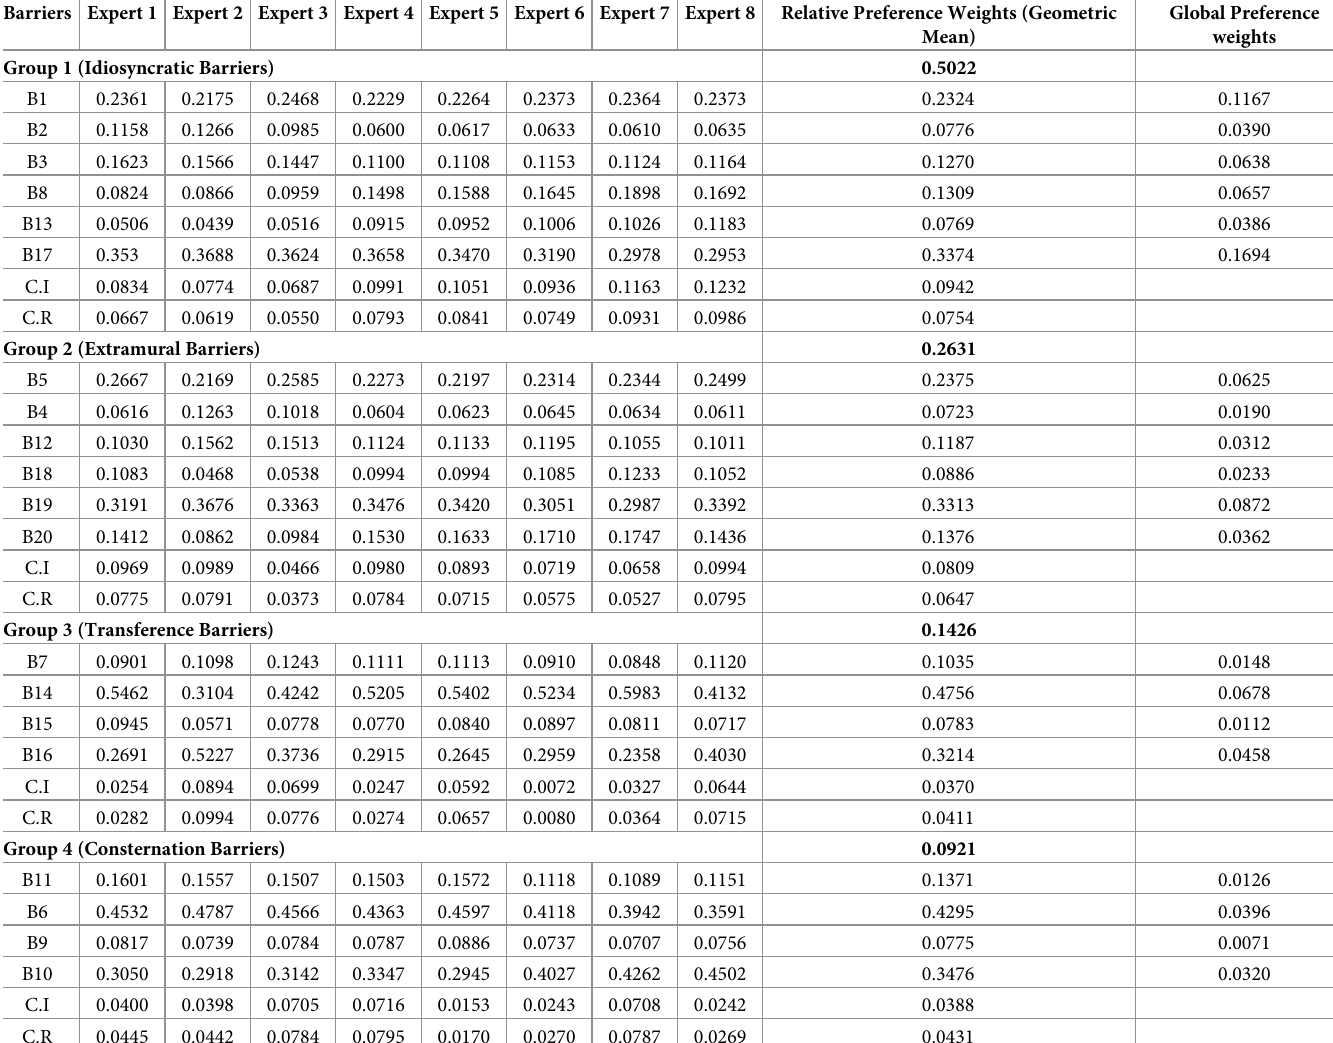
Table 2. The importance weights of all barriers (comparison of priority vectors of all the